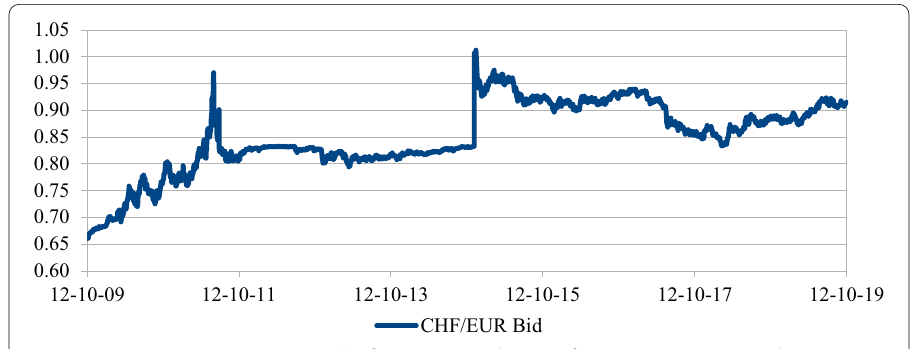
Fig. 1 Swiss Franc/Euro FX Cross Rate. This figure presents the Swiss franc to euro currency exchange price time series. In it, two price shocks can be identified, one in early August 2011 and another one on January 15th, 2015. It is clear to say that the second one was a rather sharper price shock. Source : EIKON